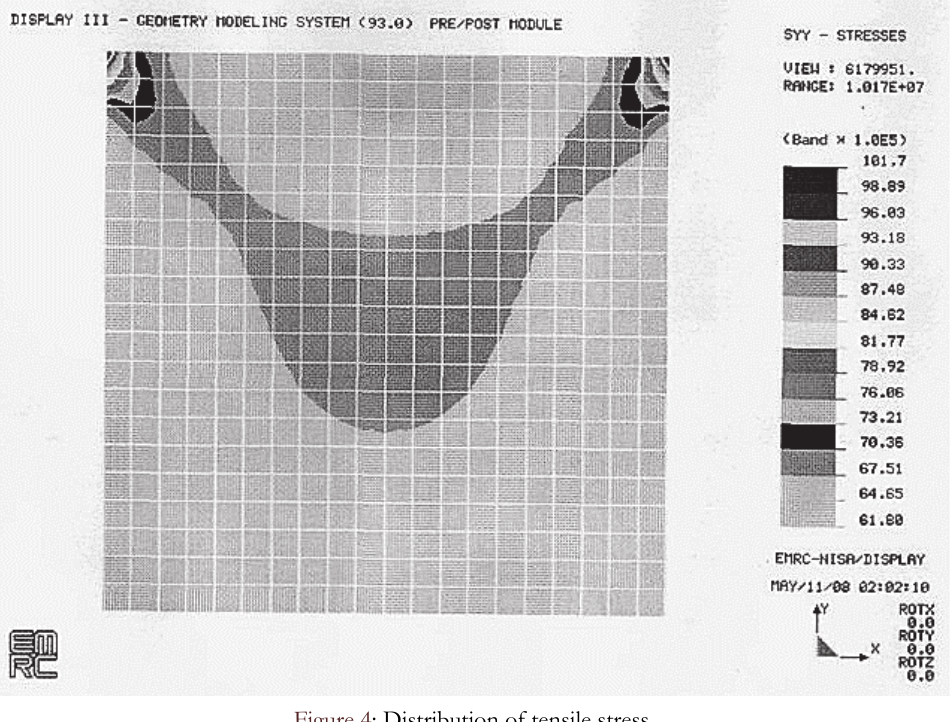
Figure 4: Distribution of tensile stress.